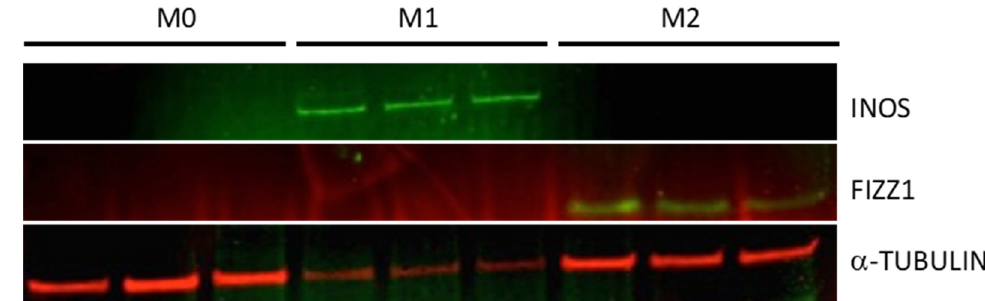
Figure 4. Western blot analyses on Naïve (M0), M1-activated, and M2-activated BMDMs.